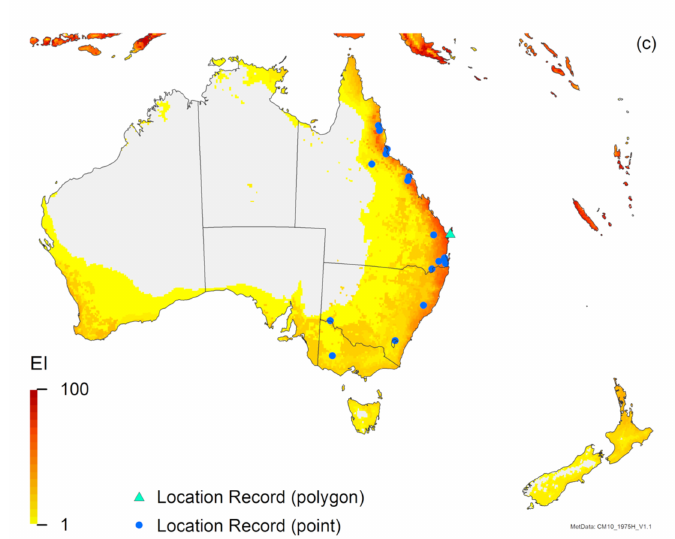
Figure 2. Modelled climate suitability (CLIMEX Ecoclimatic Index) for ( a ) Halyomorpha halys , ( b ) Trissolcus japonicus and ( c ) Trissolcus mitsukurii in Australia and New Zealand, modelled using CLIMEX Compare Locations. Suitability for all three species is mapped as a composite of natural rainfall and irrigation based on identified irrigation areas [77]. Circles are point location records; triangles are polygon